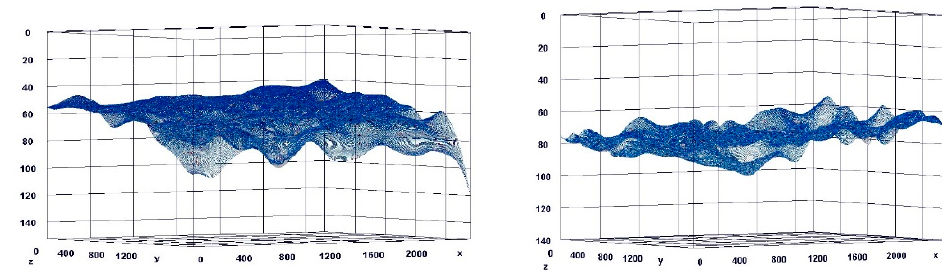
Figure 6. Segmentation before ( A ) and after ( B ) treatment (Mallory trichrome).